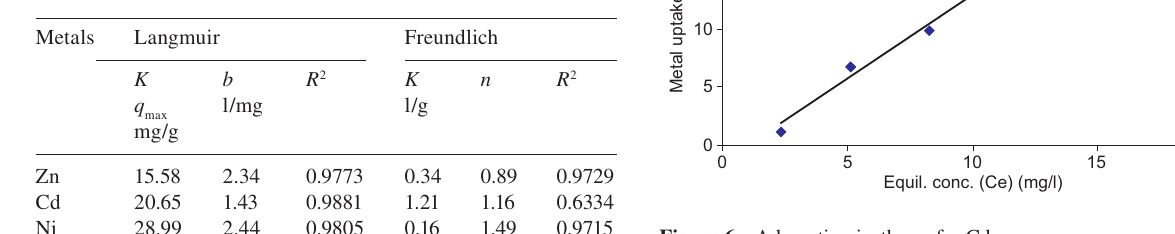
Figure 6 Adsorption isotherm for